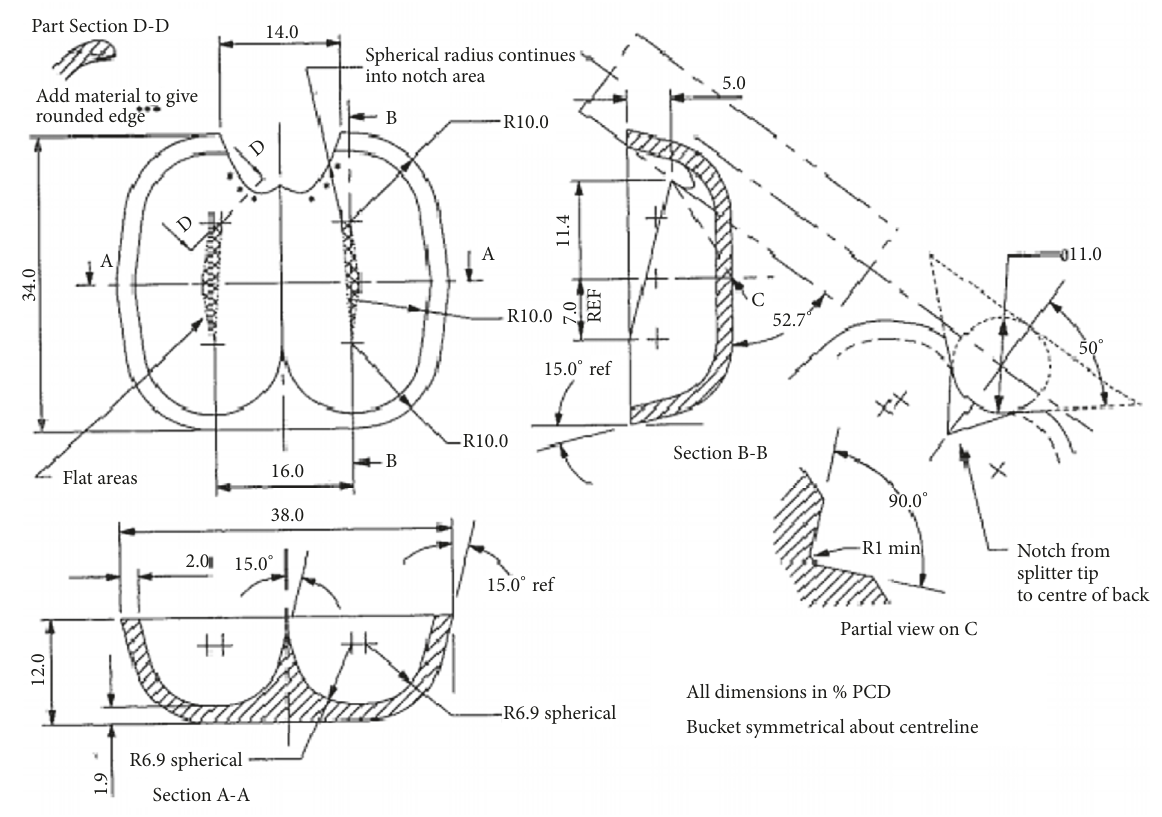
Figure 4: A scalable Pelton bucket. All dimensions are in % of PCD [6].